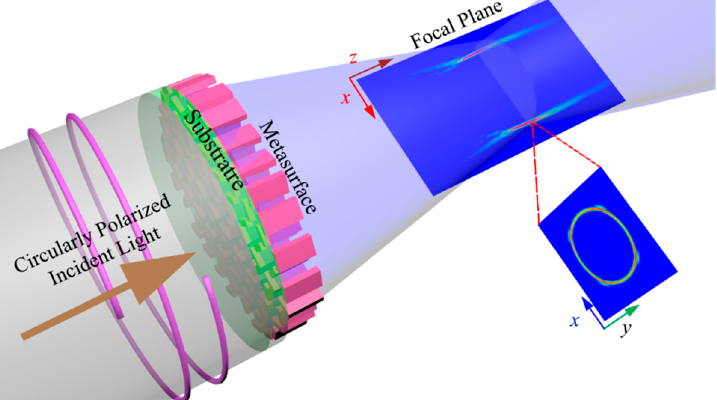
Figure 1. Working principle of silicon nitride-based perfect vortex beam-generating metasurfaces. The phase profiles of the spiral phase plate, lens, and axicon are combined and encoded to address the placement and in-plane rotation of the high-efficiency nanoantennae. Ultraviolet light with 𝜆 (cid:3031) = 300 nm impinges from the substrate side, and the diffracted light from the metasurface is captured on the outside.